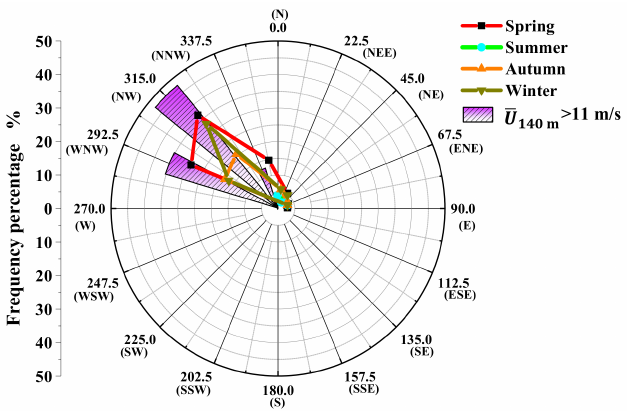
Figure 8. Wind rose diagram in different seasons based on the intense wind records at 140 m from 2013 to